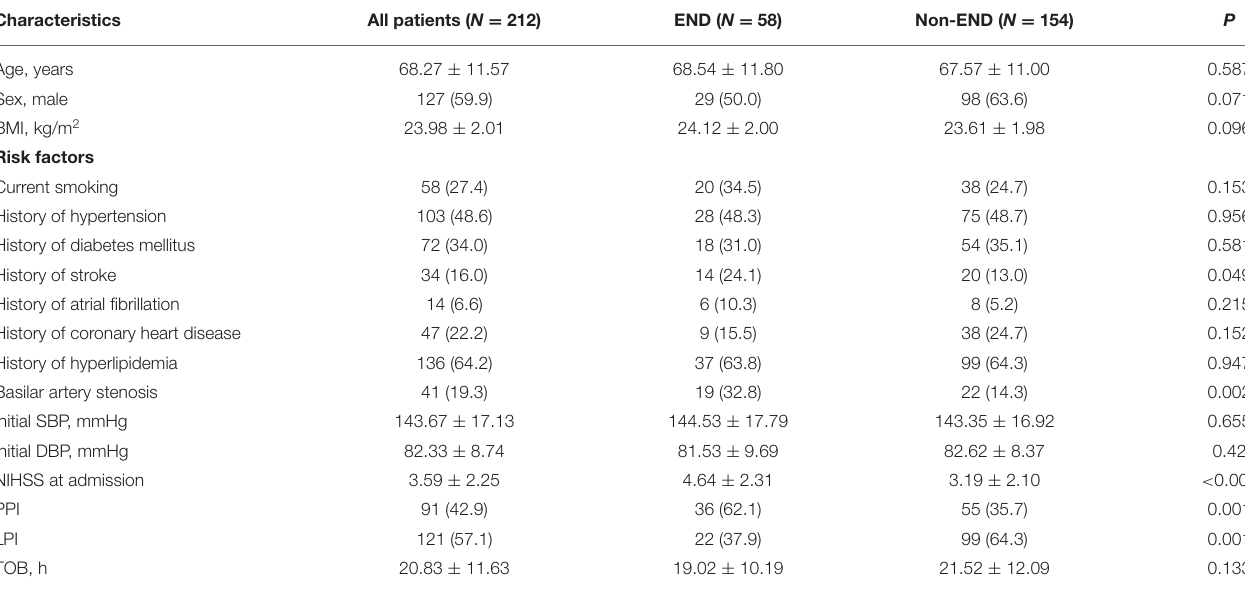
TABLE 2 | Comparison of demographic and clinical characteristics between the END non-END groups.